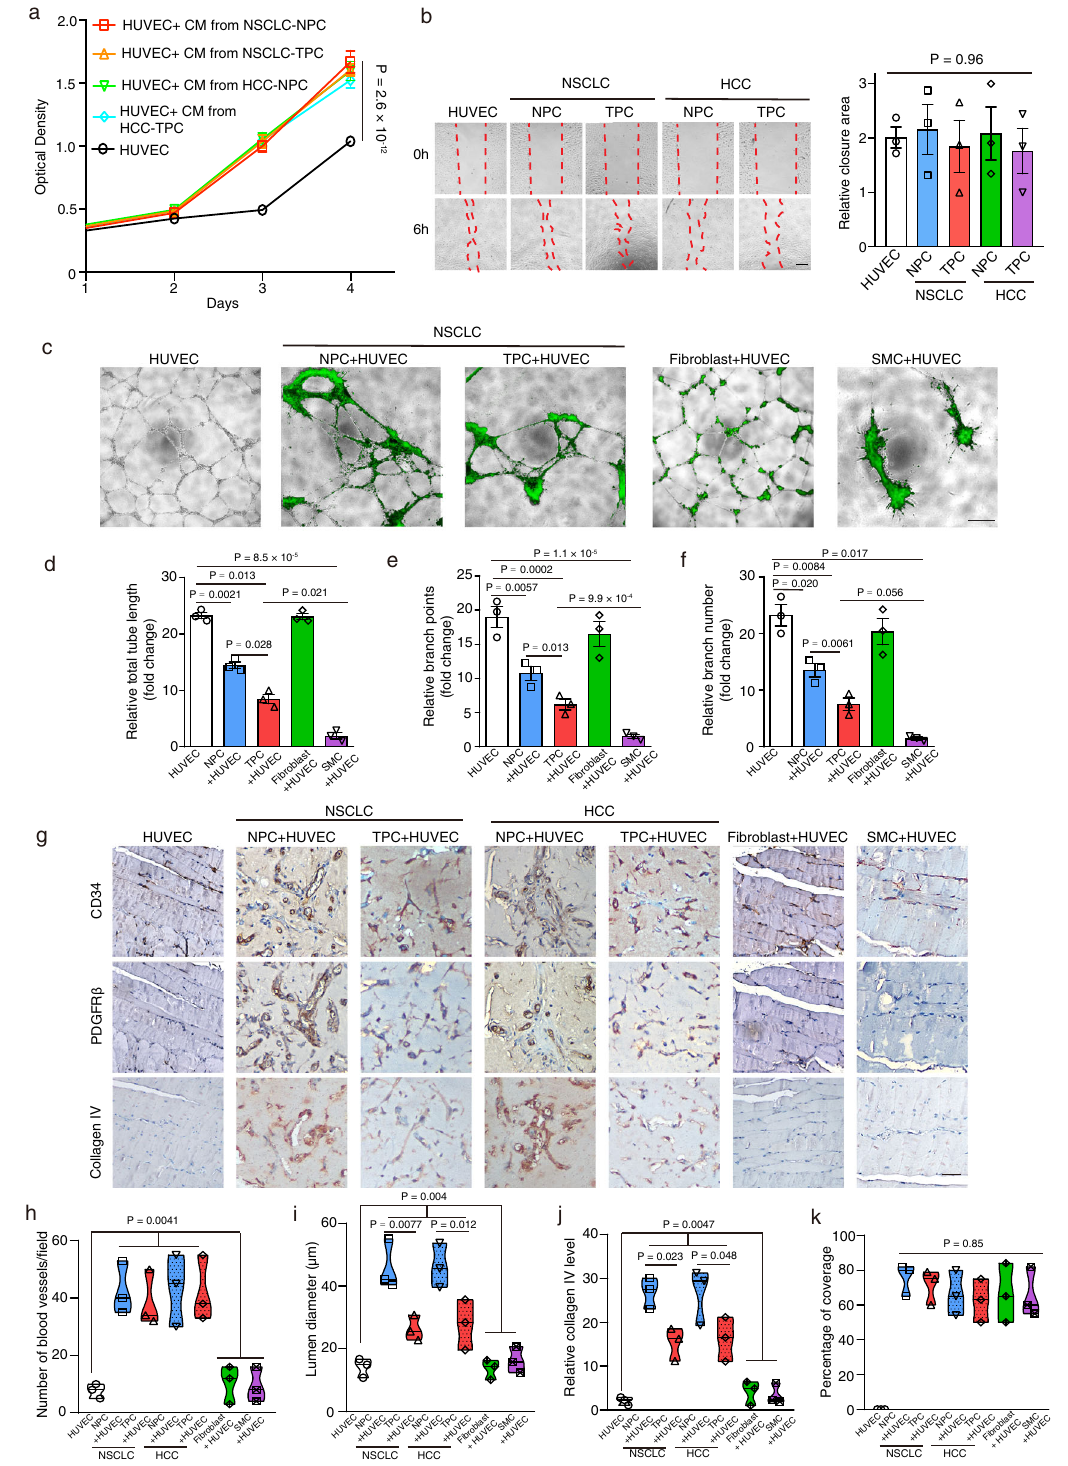
Fig. 3 Tumor-derived pericytes display defective blood vessel supporting functions in vitro and in vivo. a CCK8 proliferation assay showed that exposure with conditioned medium from NSCLC/HCC-derived NPC or TPC signi fi cantly enhanced the proliferation of HUVEC as compared to untreated HUVEC ( n = 5 experimental repeats). b Wound healing assay of the HUVEC after exposed with condition medium from NSCLC/HCC-derived NPC or TPC. Representative pictures of wound healing assay in each group are given ( n = 3 independent experiments). c HUVEC were either cultured alone or co- cultured with CFSE (green fl uorescent dye) labeled NSCLC-derived-NPC/-TPC, fi broblast or smooth muscle cells (SMC) in a tube formation assay. d – f Bar charts show the relative total tube length, branch points and number in each group ( n = 3 independent experiments). g Representative images of the serial sections of matrix plugs after immunostained with CD34, PDGFR β , or collagen IV antibody in each group are given. h – k Violin plots show the quanti fi cation of the total number of blood vessels, lumen diameter, collagen IV level and percentage of coverage in each group ( n = 3 mice per group). Results are given as means ± SEM. a Two-way ANOVA. b , d – f , h – k One-way ANOVA. Scale bars in b represents 100 μ m, c 200 μ m, g 50 μ